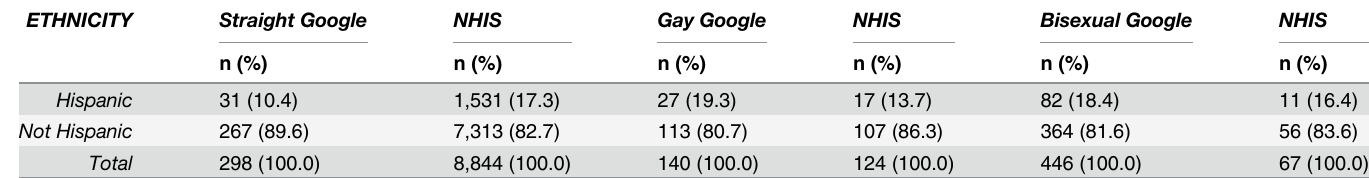
Table 5. Google Android Panel Samples and the NHIS Reported Ethnicity for Women by Sexual Orientation.